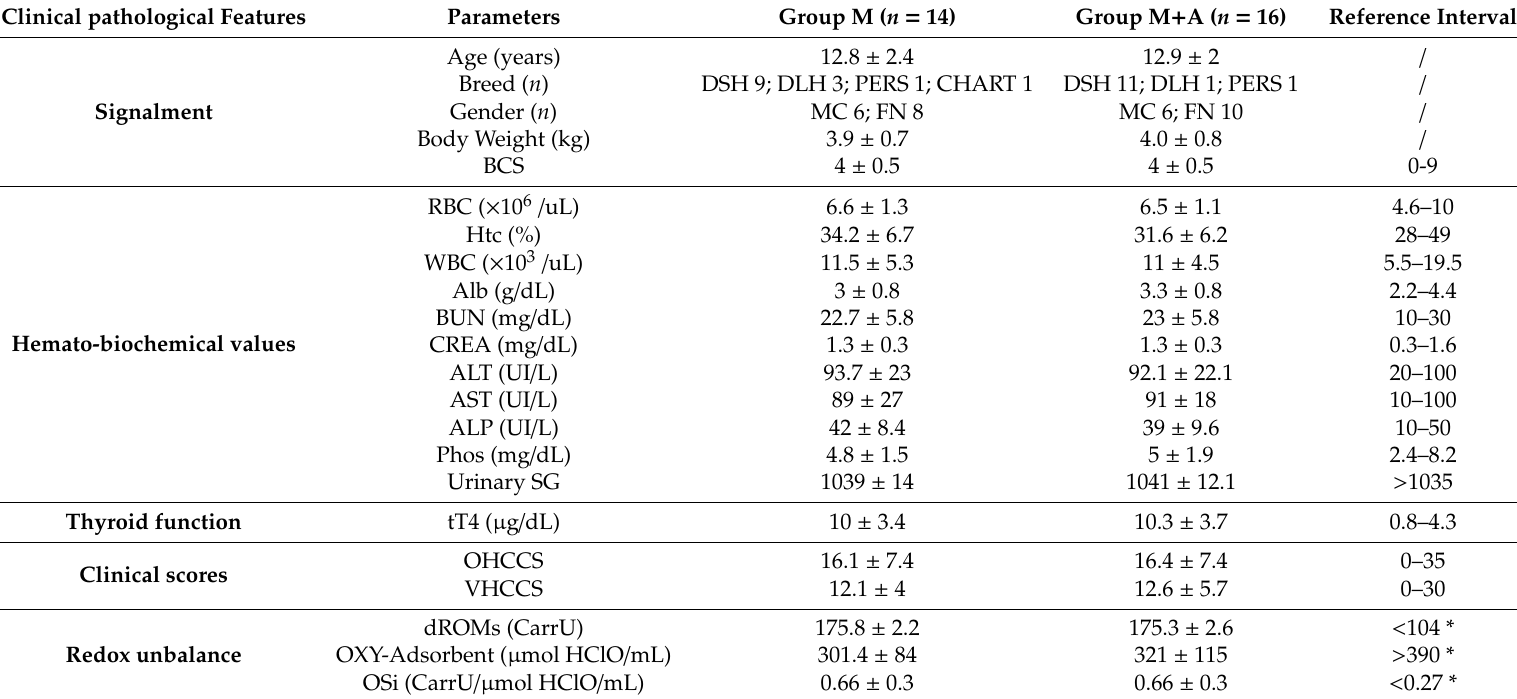
Table 2. Clinical pathological variables in hyperthyroid cats of group M (MMI + placebo) and group M + A (MMI + antioxidants) at ET. Values are expressed as mean values ± standard deviation